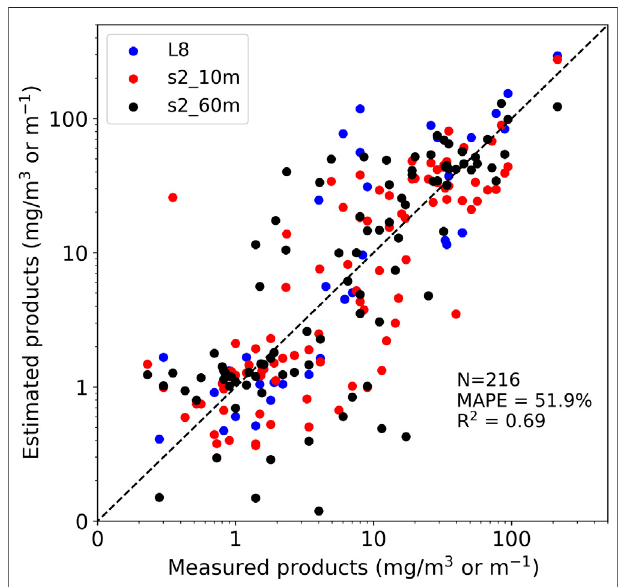
FIGURE 12 | Measured vs. estimated products; chl-a ( N (cid:2) 72), PC ( N (cid:2) 46), a g (440) ( N (cid:2) 46), and C nap ( N (cid:2) 46) for same day matchups from L8 and